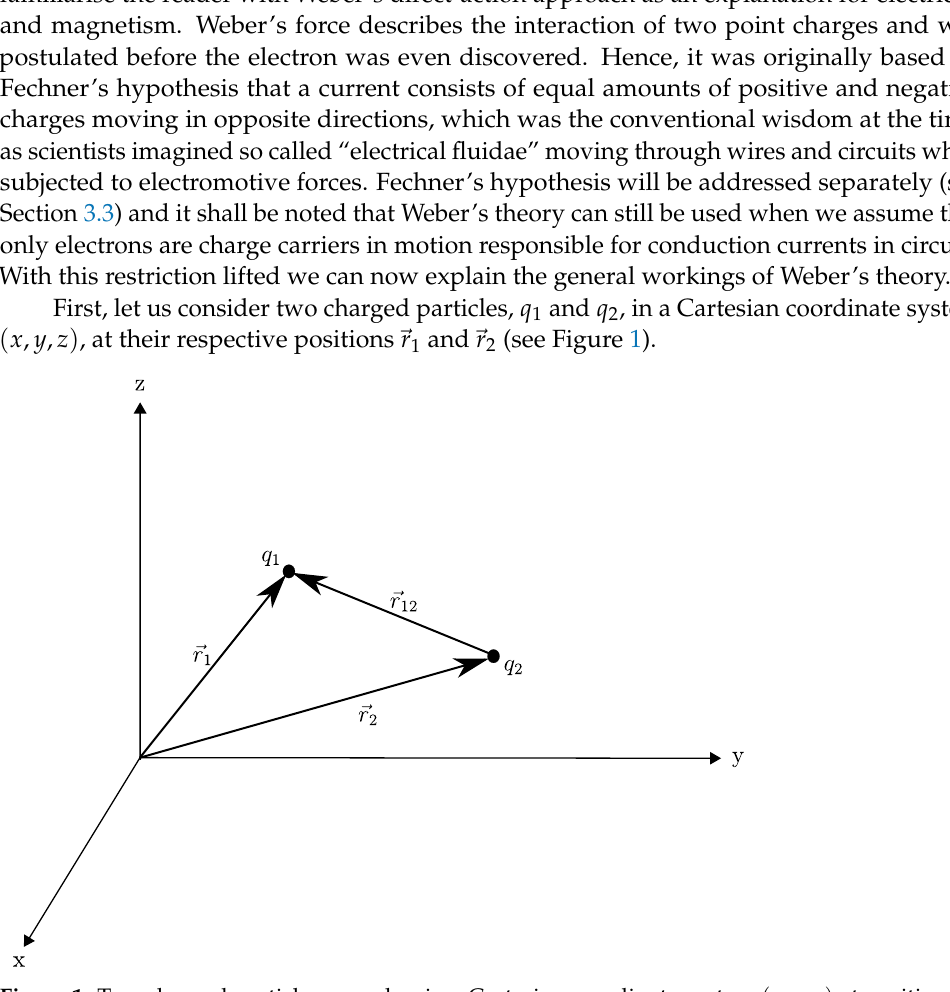
Figure 1. Two charged particles q 1 and q 2 in a Cartesian coordinate system ( x , y , z ) at positions (cid:126) r 1 and (cid:126) r 2 . Their relative position (cid:126) r 12 is a vector pointing from q 2 to q 1